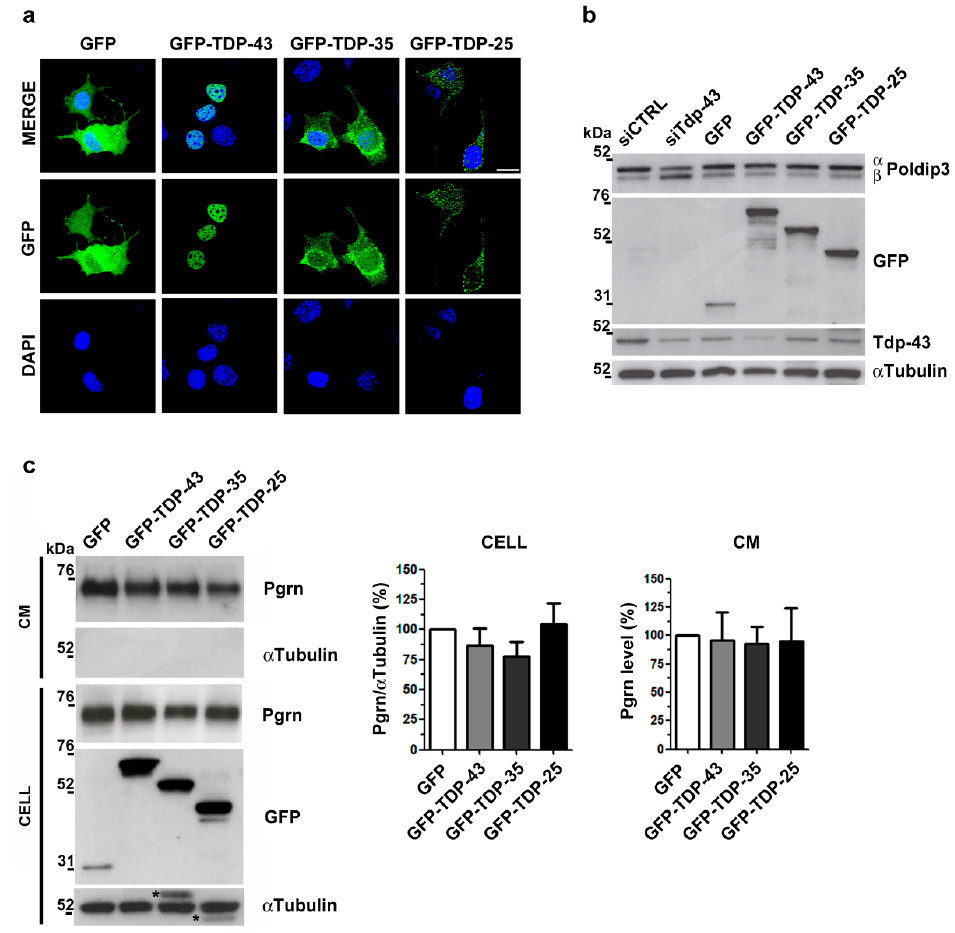
Figure 2. Pgrn protein content and secretion in murine TDP-43 gain-of-function (GOF) cells. ( a ) Representative immunofluorescence images showing the subcellular localization of the recombinant GFP-TDP-43 full length and C-terminal fragments (GFP-TDP-35; GFP-TDP-25) in NSC-34 cells. DAPI (blue) was used for nuclei staining. Scale bar: 10 µm. ( b ) Representative WB images of Poldip3 protein isoforms ( α and β ) in NSC-34 cells knocked-down for Tdp-43 (siTdp-43) or expressing GFP-TDP-43, GFP-TDP-35 and GFP-TDP-25 constructs as indicated. Immunoblots with anti-GFP and anti-Tdp-43 antibodies were performed to assess TDP-43 over-expression and gene silencing efficiencies, respectively. Upon GFP-TDP-43 over-expression, autoregulation of the endogenous Tdp-43 protein could be observed. α Tubulin was used for sample normalization. ( c ) Representative WB images and densitometric analyses of Pgrn protein content in cell lysates (CELL) and conditioned media (CM) of NSC-34 cells transfected as indicated. α Tubulin was used for sample normalization and as non-secreted control protein in CM (mean ± s.e.m.; n = 3 independent experiments; one-way ANOVA and Bonferroni’s multiple comparison post hoc test) *, residual signal from previous anti-GFP hybridization.